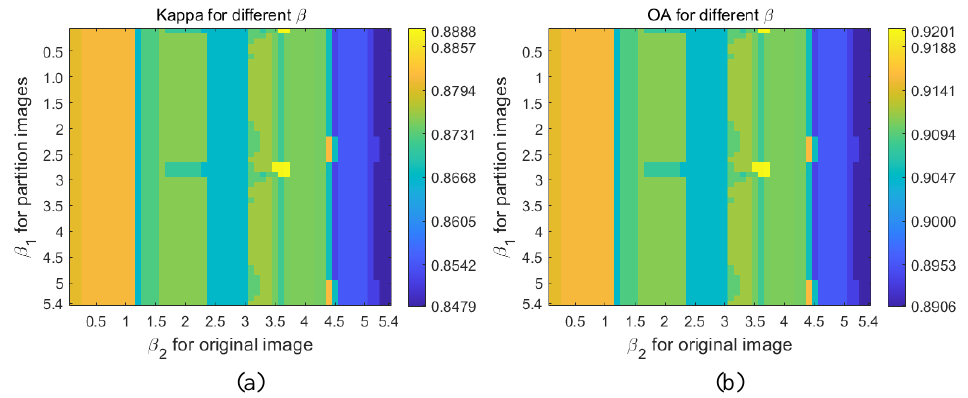
Figure 5. Kappa and OA for different β (potential energy parameter) from 0.1 to 5.4 with step 0.1: ( a ) Kappa for different β ; ( b ) OA for different β